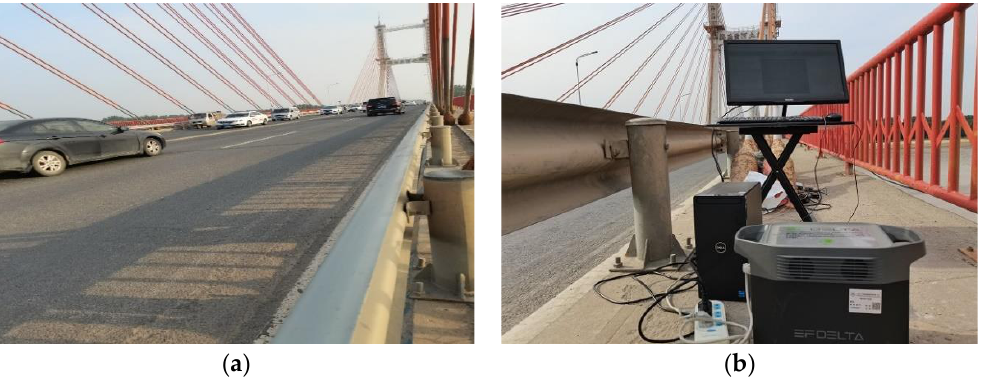
Figure 4. Experiment site: ( a ) panoramic view of Jinan Yellow River Bridge; ( b ) device connection.